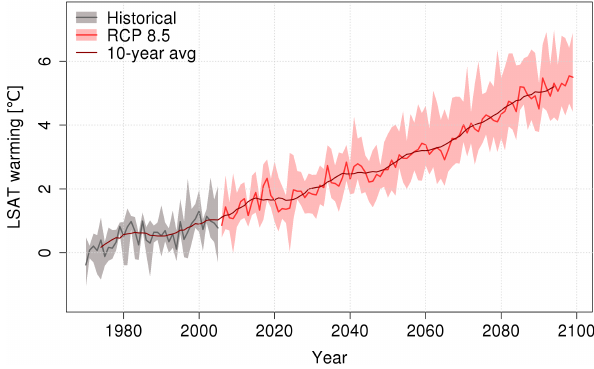
Figure 3. Land surface air temperature warming of the ensemble of seven EURO-CORDEX climate projections compared to pre- industrial times.